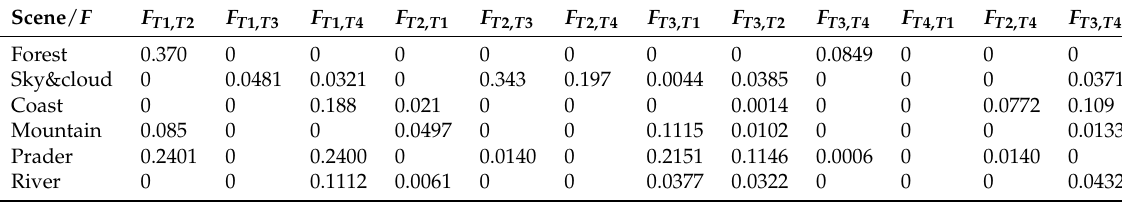
Table 5. Final τ values, applying the better individuals of the GA.